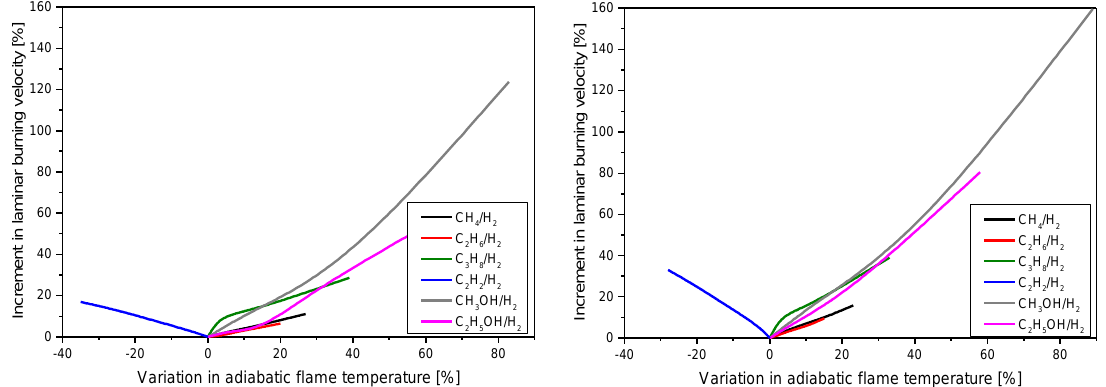
Figure 4. Increment of laminar burning velocity with increment in adiabatic flame temperature for lean ( left ) and stoichiometric ( right ) compositions.